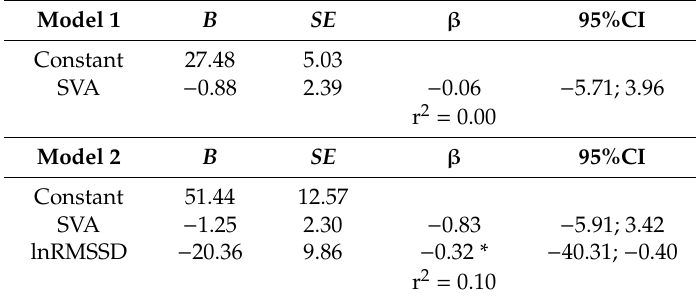
Figure 3. Number of ventricular arrhythmias following administration of isoproterenol in the low HRV (n = 20) and high HRV (n = 21) groups. Data are expressed as mean ± SEM. The median split of lnRMSSD values (1.15) during 24-h recordings was used to divide the population into these two groups. The rat that died shortly after isoproterenol administration was not included in these analyses. HRV = heart rate variability; lnRMSSD = natural logarithm of the root mean square of successive beat-to-beat interval di ff erences; * = p < 0.05. Table 3. Summary of the hierarchical regression analysis for variables predicting the total number